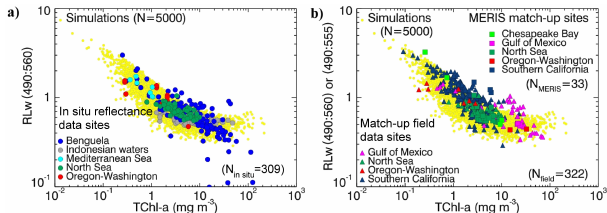
Figure 25. Reflectance band ratio 490:560 vs. CHL concentra- tions (mgm − 3 ) from (a) the in situ reflectance data set and from (b) MERIS RLw products and match-up field RLw measurements (using band 555nm instead of 560nm) with the associated match- up field TChl a concentrations, both superimposed on the simulated reflectance band ratio 490:560 vs. the simulated CHL (yellow cir- cles). Match-up field TChl a data are restricted to measurements collected within 1h after/before the time of MERIS overpass, and to the maximum measurement depth of 2m.